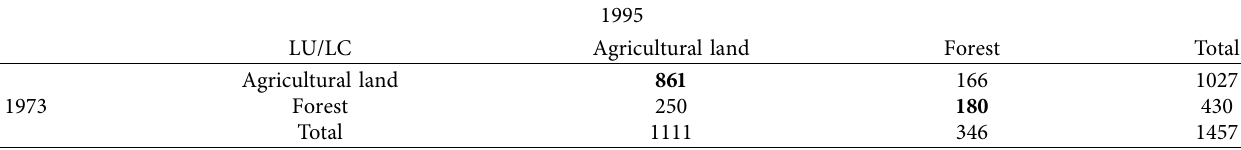
Table 6: Land use/land cover change matrix (ha) between 1973 and 1995.